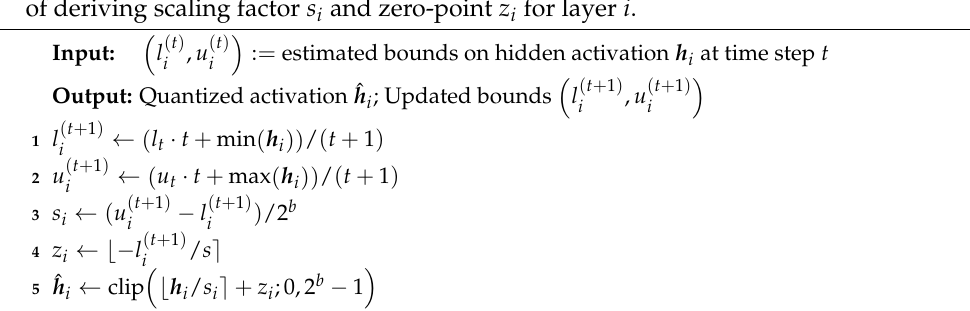
Algorithm 2: Our adaptive asymmetric quantization algorithm for our activa- tions h i using per-tensor scaling factors. We use moving average statistics over hidden activation h i to estimate the bounds on its dynamic range for the purpose of deriving scaling factor s i and zero-point z i for layer i